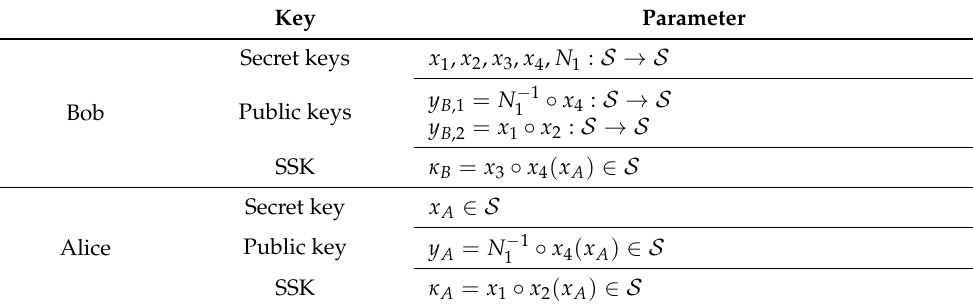
Table 1. Complete list of key of